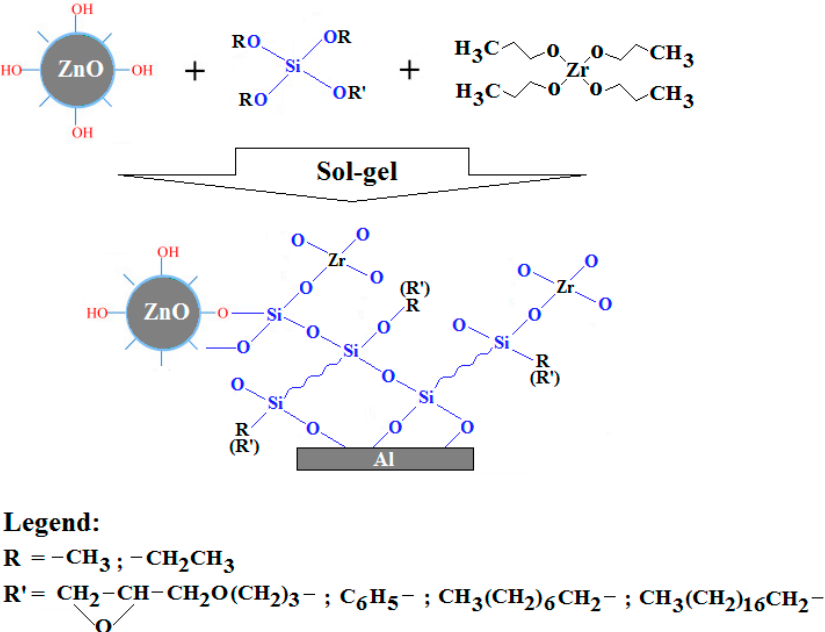
Figure 1. Probable reaction mechanism that can occur when ZnO is modified using silane precursors.